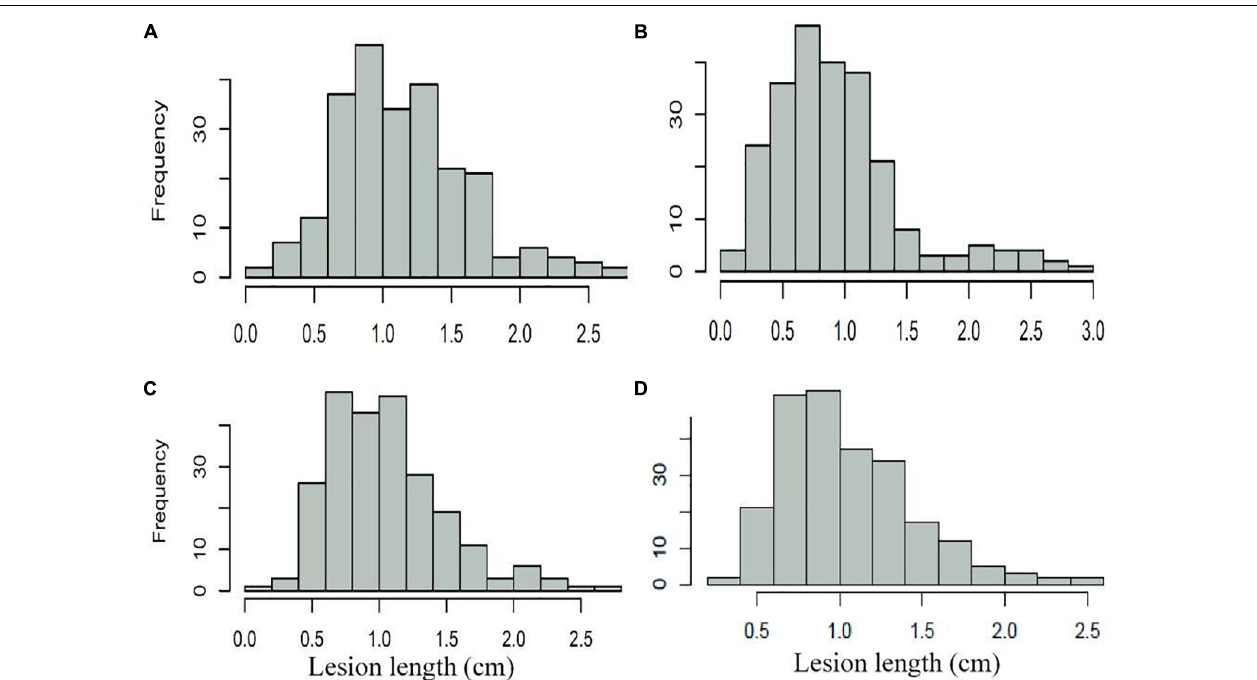
FIGURE 1 | Frequency distribution of Fusarium seeding blight of 240 wheat cultivars (lines). (A) FSB_Rep1; (B) FSB_Rep2; (C) FSB_Rep3; and (D)